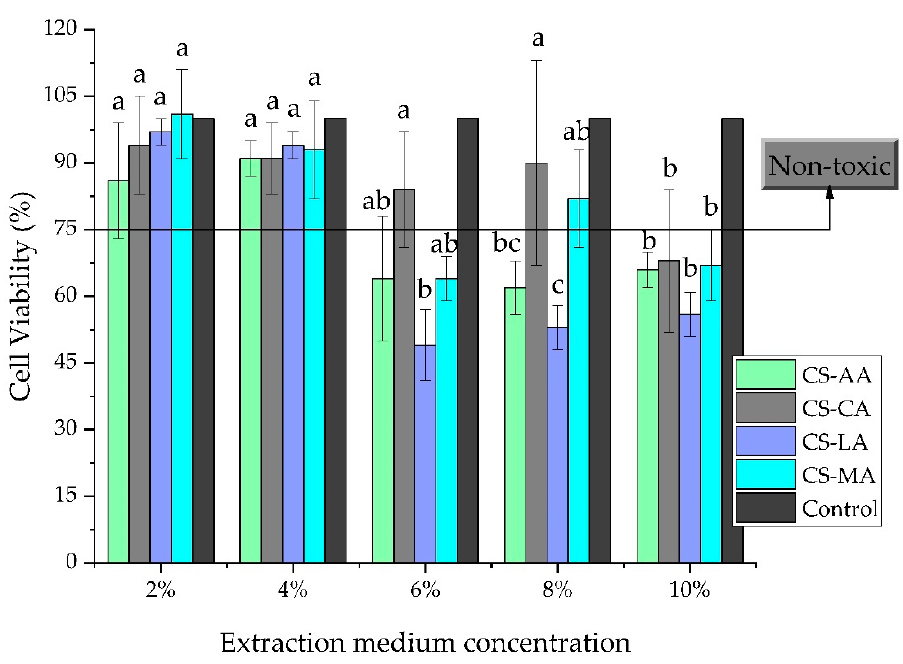
Figure 6. Cytotoxicity of shrimp chitosan films prepared with acetic, citric, lactic, and maleic acids (CS-AA, CS-CA, CS-LA, and CS-MA) in BJh-TERT human fibroblast cells for 7 days after cell seeding at five different concentrations of the film extract in PBS medium (2%, 4%, 6%, 8% and 10%). Same letter indicates that there is no significant difference ( p > 0.05) by the Tukey’s test.